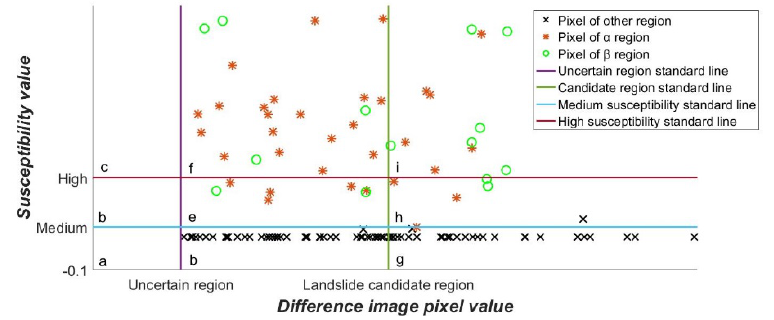
Figure 12. Scatter plot of sub-area A.